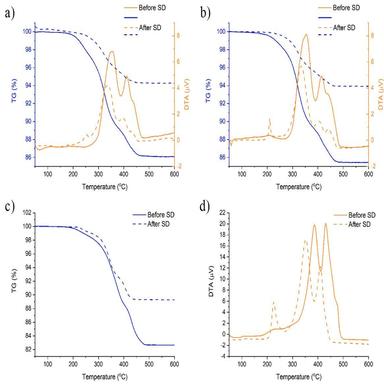
STA analysis of the three different YSZ filaments (SiCeram, PT+A, and Fabru) before and after solvent debinding; a) shows the STA signal of the SiCeram, b) PT+A,c) TG signal, and d) DTA signal for Fabru filaments.